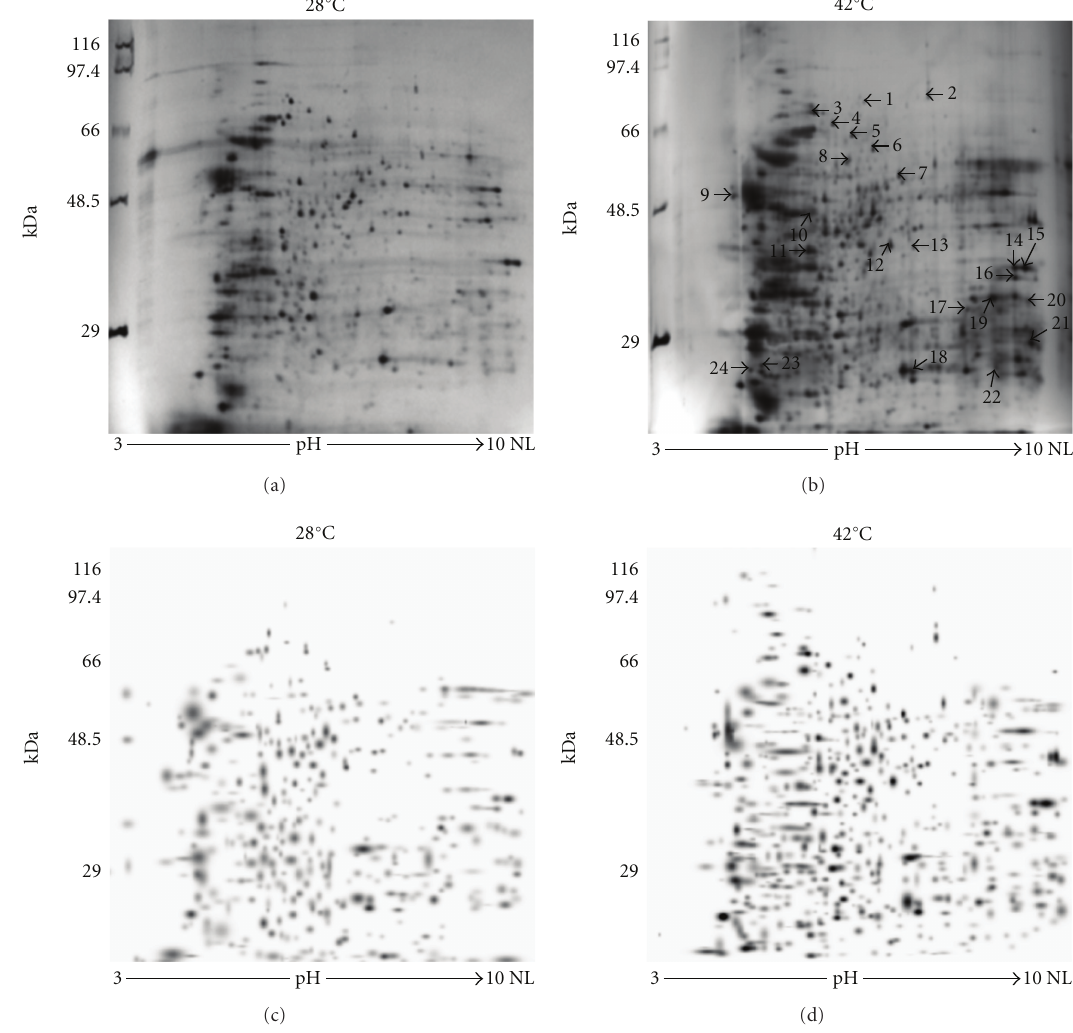
Figure 2: 2-DE polyacrylamide gels of control and heat-treated parasite extracts. (a) and (b) Silver-stained 2-DE gels of soluble proteins (300 μ g per gel) from T. cruzi epimastigotes at normal growth (28 ◦ C, 3h) (a) or heat shock (42 ◦ C, 3h) temperatures (b). The proteins were firstly separated in a pH range of 3–10 NL and then on 10% SDS-PAGE. An average of 506 ± 73 spots were found in gels from parasites incubated at 28 ◦ C, and gels obtained from heat-shocked parasites had an average of 521 ± 31 spots. The molecular standards are indicated in kDa. The gels are representative of three independent experiments. In 2-DE gel from 42 ◦ C, the spots indicated by numbers were identified by MS (Table 1). (c) and (d) Master gels of control (c) or heat shock conditions (d). Three gel images obtained from di ff erent experiments from each condition (28 ◦ C or 42 ◦ C) were aligned and matched each other to generate an average master gel using the PDQuest